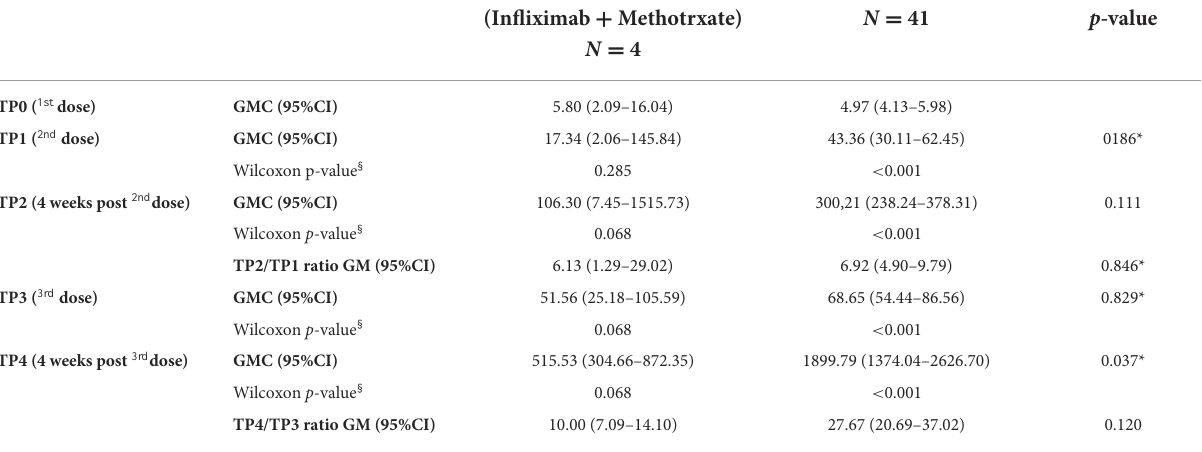
TABLE 3 Geometric mean of concentration (GMC) and GM ratios of anti SARS-CoV-2 spike protein IgG at different time points according to different treatment